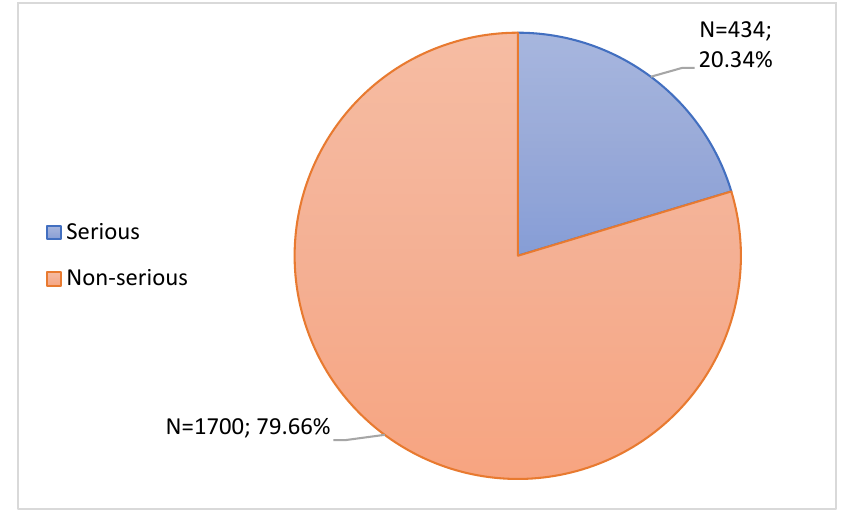
Figure 8. Characterization of notifications according to seriousness.